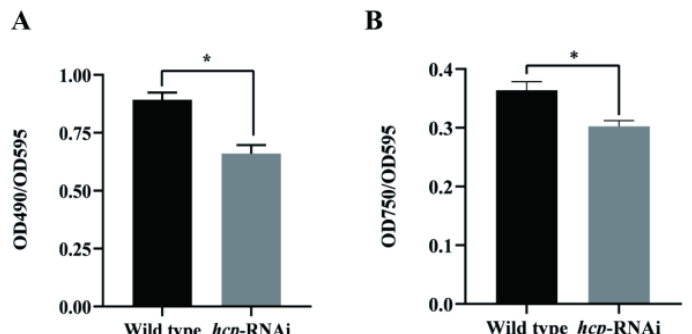
Figure 8. Effects of hcp gene silencing on the content of extracellular polysaccharides ( A ) and extracellular proteins ( B ) in A. salmonicida . Data are presented as mean ± SD. Three independent biological replicates were performed per group. * p < 0.05.